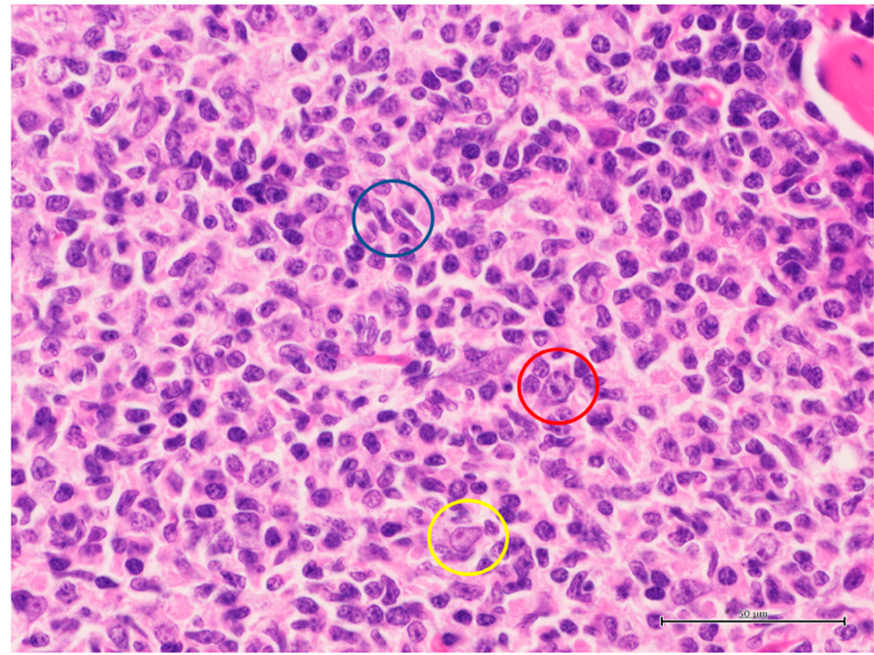
Figure 3. Cytotypes in PCFCL. Blue circle: large centrocytes, characterized by stretched irregular nuclei; red circle: centroblast, characterized by a roundish nucleolus with single prominent nucleolus; yellow circle: follicular dendritic cell, characterized by a poorly defined cytoplasm and an oval nucleolus with poorly evident nucleolus (hematoxylin and eosin stain, original magni fi cation 400×).